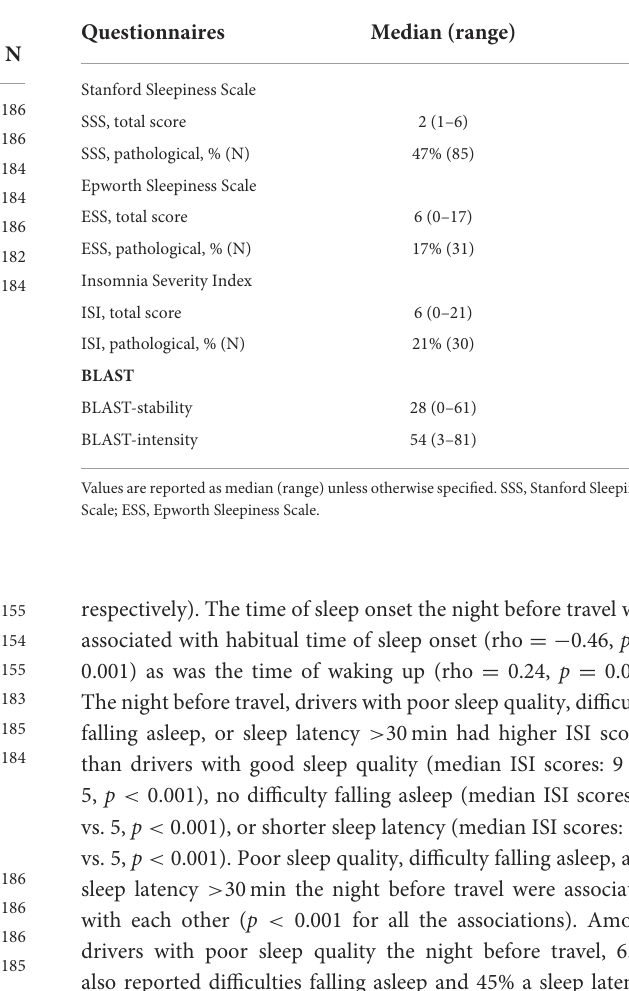
TABLE 2 Questionnaires and BLAST